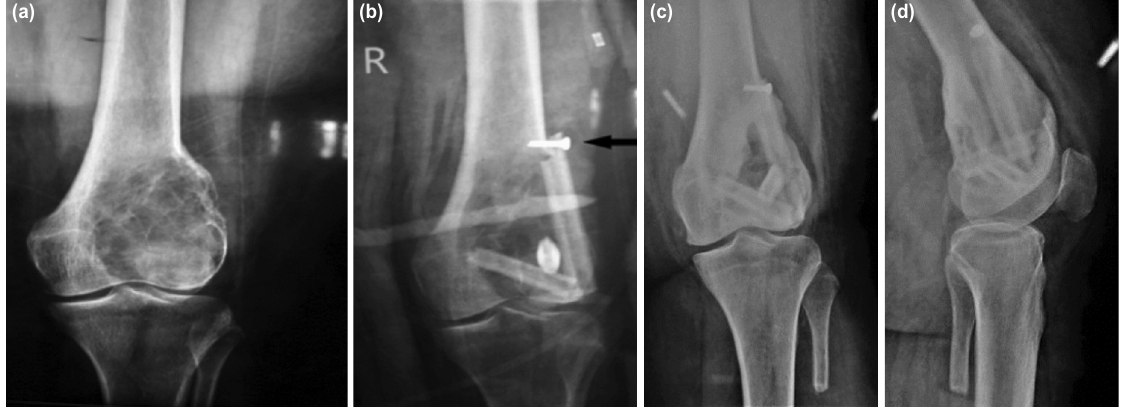
(a) Giant cell tumour involving the lateral femoral condyle in 24-year-old. (b) Cavity was supported with three struts after Fig. 2: curettage. Arrow indicates a 3.5mm cortical screw used to secure the superoinferior strut to the lateral femoral cortex. (c,d) Good consolidation of the graft at two years post-operation.